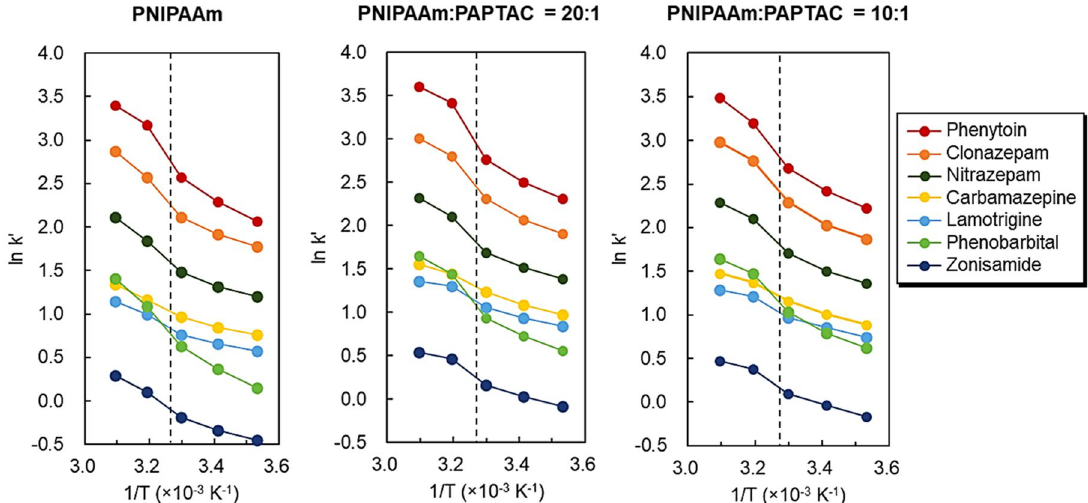
Figure 7. van’t Hoff plots of the antiepileptic drugs on the prepared mixed-mode columns. The dashed line indicates the phase transition temperature of PNIPAAm. (Figures were drawn Microsoft PowerPoint 2019 Version